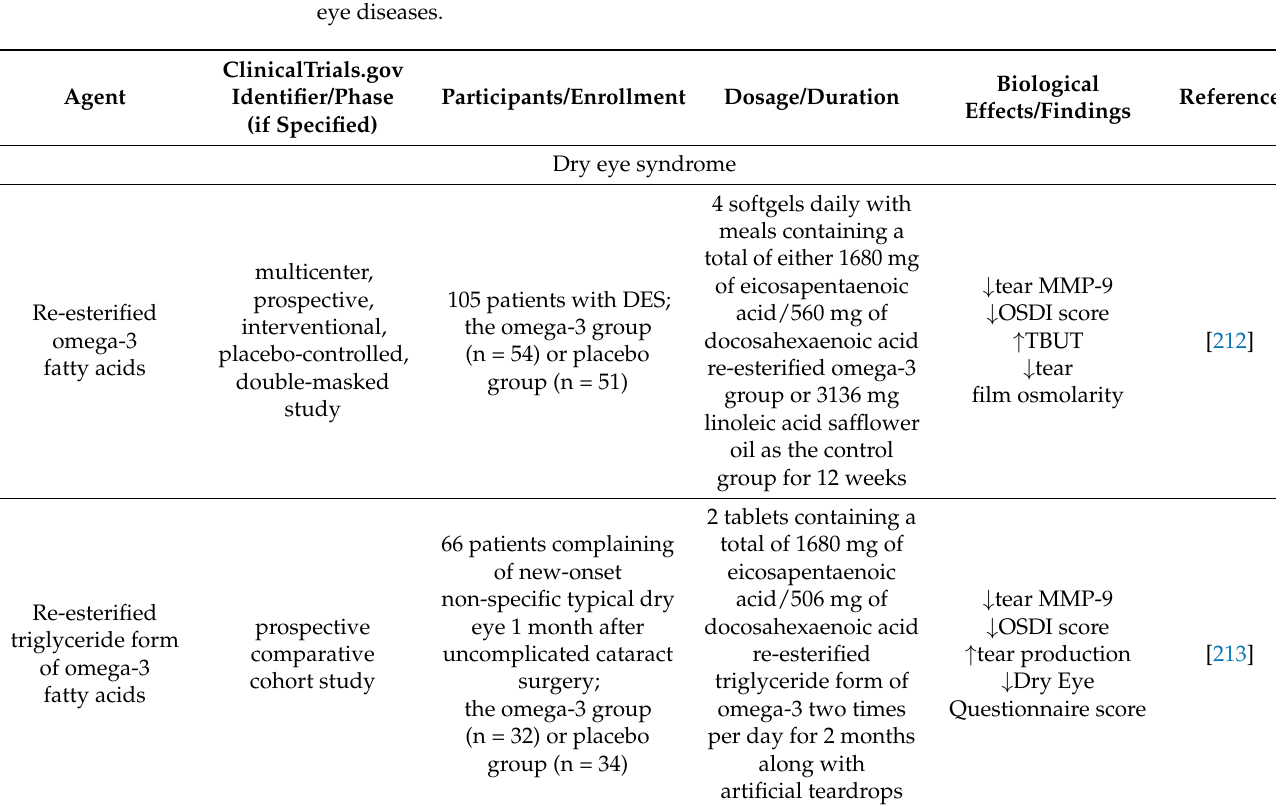
Table 3. Overview of clinical studies associated with the modulation of MMPs and TIMPs in eye